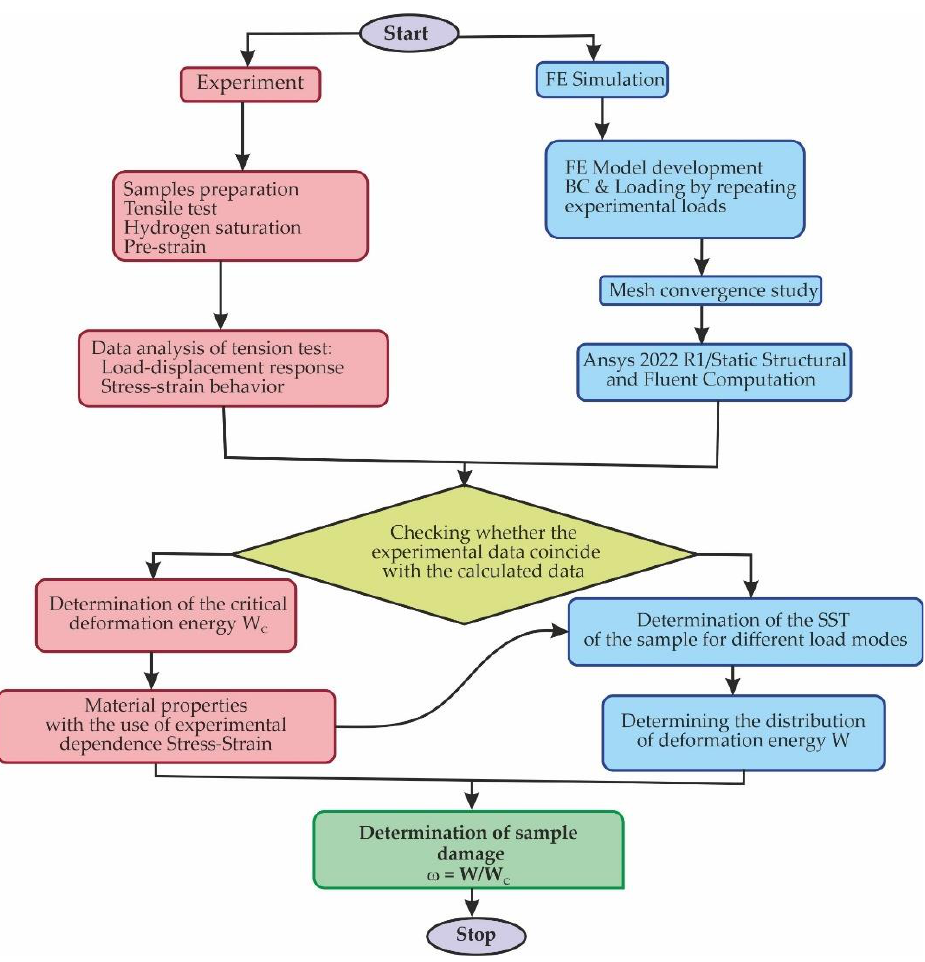
Figure 5. Block diagram of research methodology.